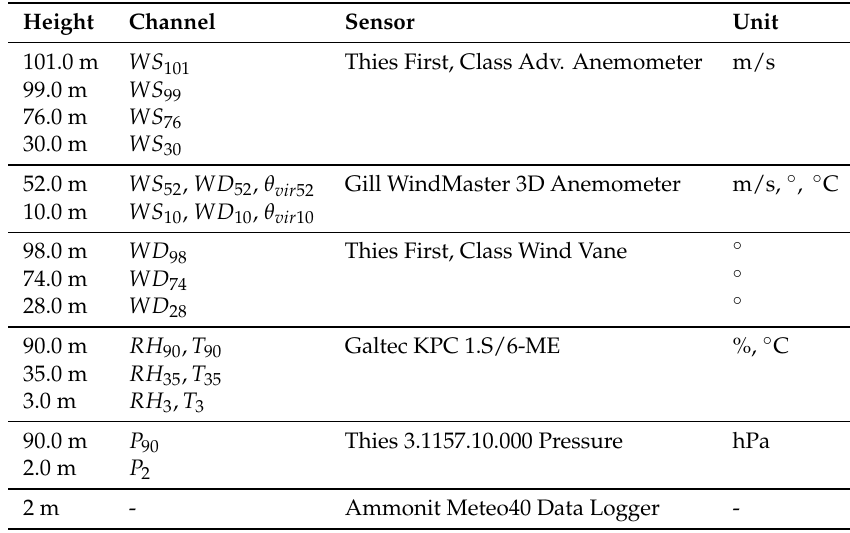
Table 1. IZTECH 100 m met mast